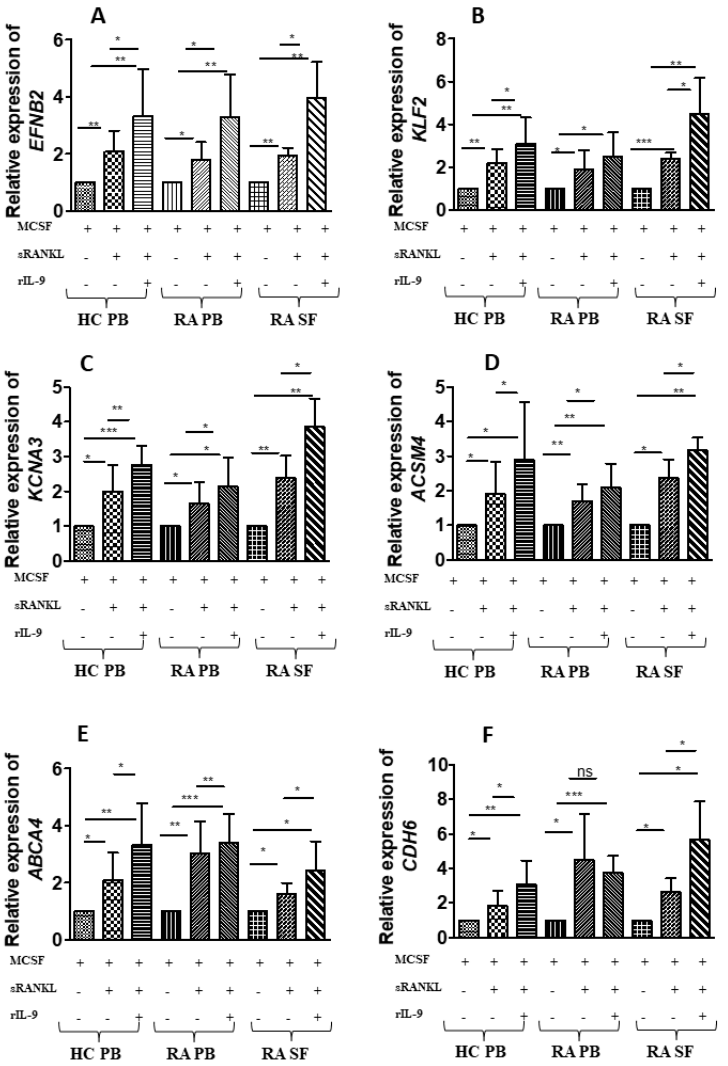
Figure 4. Validation that IL-9 induced six differentially expressed genes during osteoclast differen- tiation. ( A – F ) Cells derived from peripheral blood (PB) of healthy control (HC) and cells derived from PB and synovial fluid (SF) of patients with RA were treated as indicated with macrophage colony-stimulating factor (M-CSF; 25 ng/mL), soluble receptor activator of nuclear factor κ B ligand (sRANKL; 50 ng/mL), or IL-9 (100 ng/mL) for 4 days. Cells were then lysed followed by RNA extraction and cDNA preparation from an equal quantity of RNA. Glyceraldehyde phosphate dehy- drogenease (GAPDH) was used as an internal control for validation of the differentially expressed genes, as the expression of GAPDH showed least variation with stimulation. Quantitative real-time PCR (RT-PCR) was performed for ephrinB2 (EFNB2), ATP-binding cassette subfamily A member 7 (ABCA7), Krueppel-like factor 2 (KLF2), cadherin 6 (CDH6), acyl-coenzyme A synthetase (ACSM4), and potassium voltage-gated channel subfamily A member 3 (KCNA3). The graphs represent the relative expression of these genes (mean ± SD; n = 8). Statistical analysis was performed using paired Student’s t -test comparing M-CSF/sRANKL/rIL-9-treated cells to M-CSF/sRANKL-, M-CSF-, and M-CSF/sRANKL-treated cells to M-CSF (*: p ≤ 0.05; **: p ≤ 0.005; ***: p ≤ 0.0005; ns–non